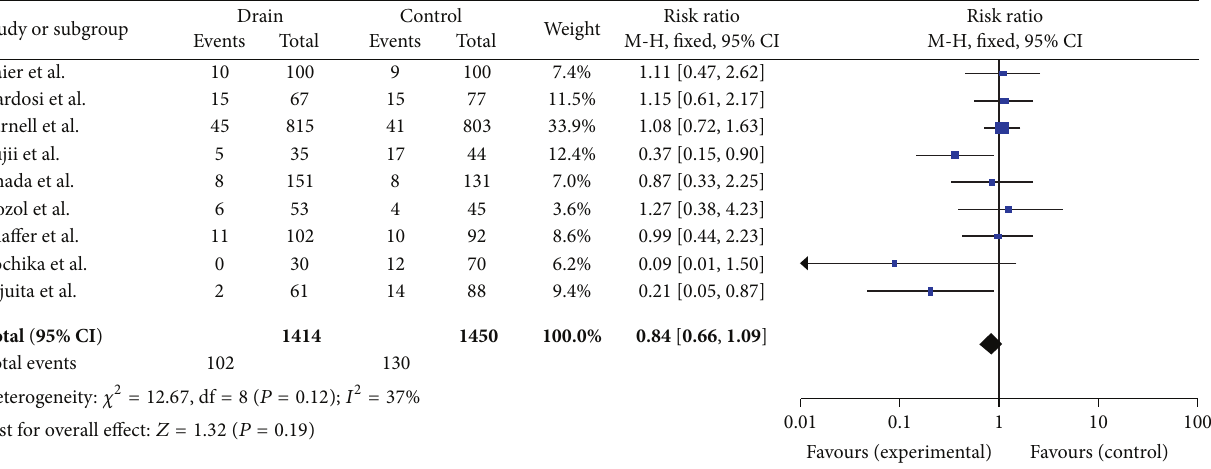
Figure 2: Forest plot data comparing ten trials from Table 1.